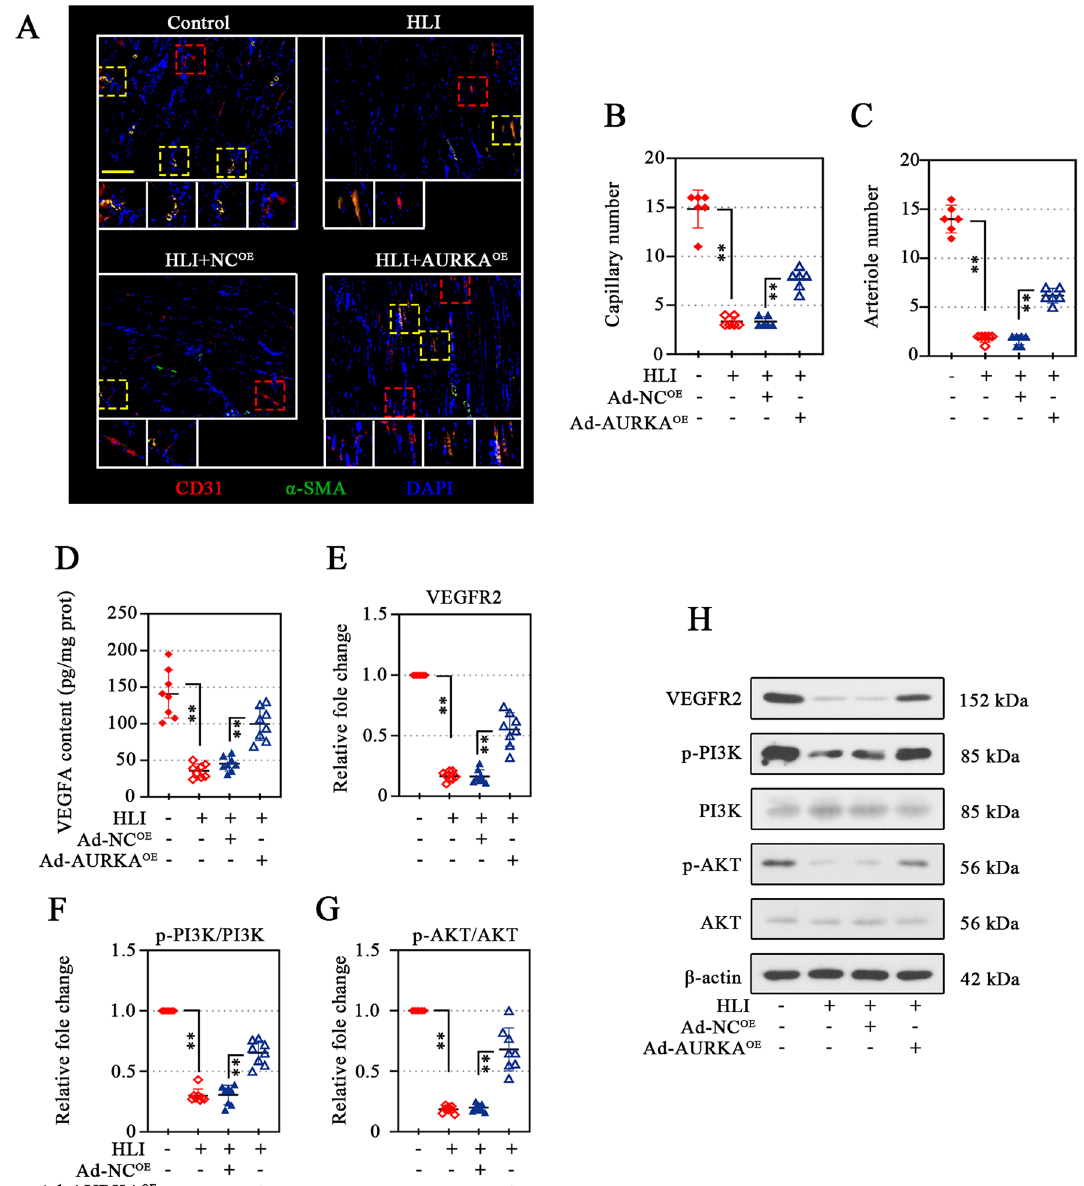
Fig. 8 AURKA overexpression improved angiogenesis in ischemic gastrocnemius muscle of diabetic mice. After 21 days of modeling, dual-immunofluorescence analysis in gastrocnemius muscle tissues was conducted to visualize CD31 and α-smooth muscle actin (α-SMA). Scale bar, 200 μm ( A) . The capillaries (CD31 + /α-SMA − , red box identification) ( B ) and arterioles (CD31 + /α-SMA + , yellow box identifications) ( C ) was quantified. The VEGFA content of gastrocnemius muscle tissues was determined ( D ). Protein levels in gastrocnemius muscle tissues of VEGFR2 ( E ), p-PI3K ( F ), PI3K ( F ), p-AKT ( G ), and AKT ( G ) were analyzed using Western blotting ( E – H ). Data were represented as mean indicated a biological replicate, n =